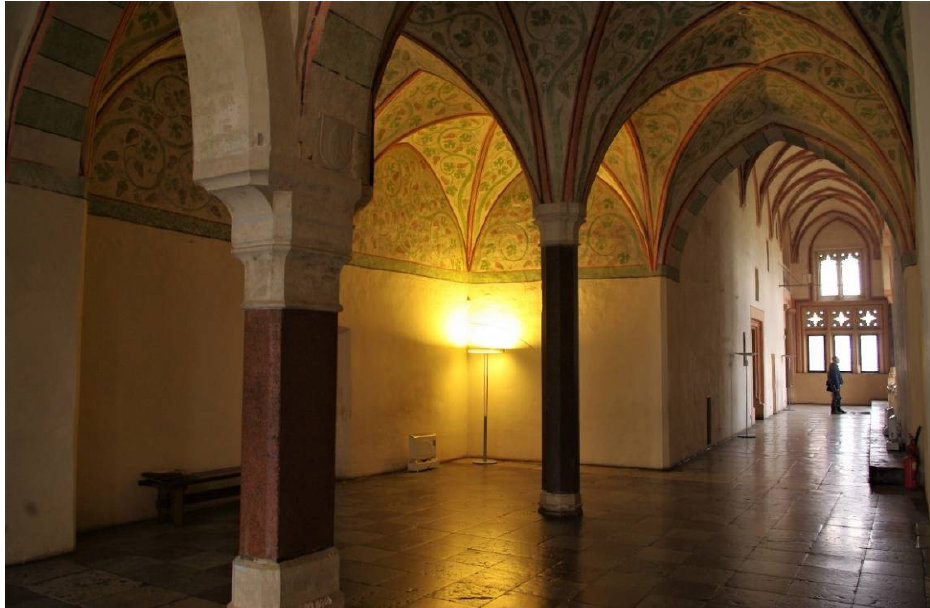
Figure 15. Malbork, Marienburg castle, Grand Master’s Palace, High Vestibule, probably 1380–1385. Photo by Tomasz Ratajczak, the author’s own work.